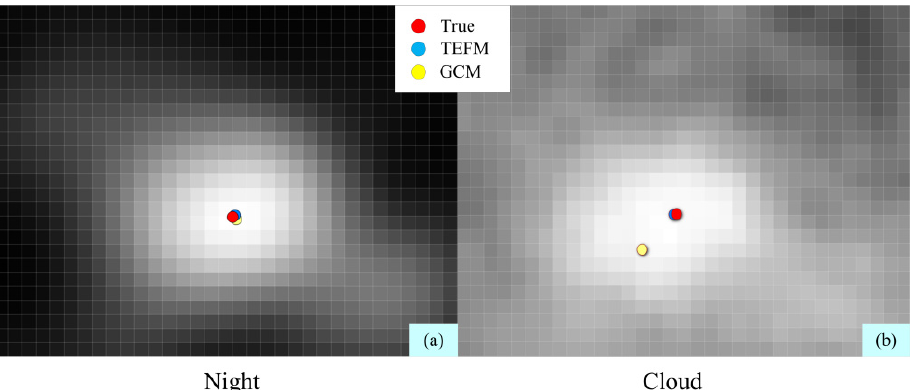
Figure 5. Accuracy evaluation of the proposed algorithm. Red, blue, and yellow dots correspond to the centroid calibration position, ( a ) the centroid extraction result of the ellipse-fitting method (TEFM), and ( b ) the centroid extraction result of the gray centroid method (GCM), respectively.